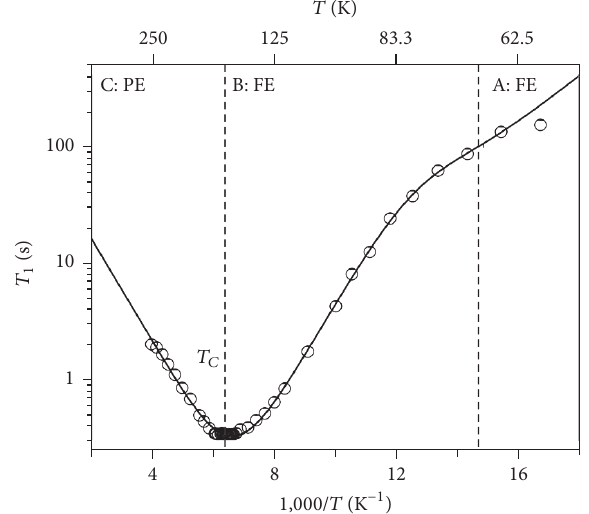
Figure 5: The proton T 1 as a function of the inverse temperature T −1 . A, B, and C refer to glassy, ferroelectric (FE), and paraelectric (PE) states. And two characteristic temperatures are 40 K and 156K. Reprinted with permission from Ref. [56]. Copyright 2011